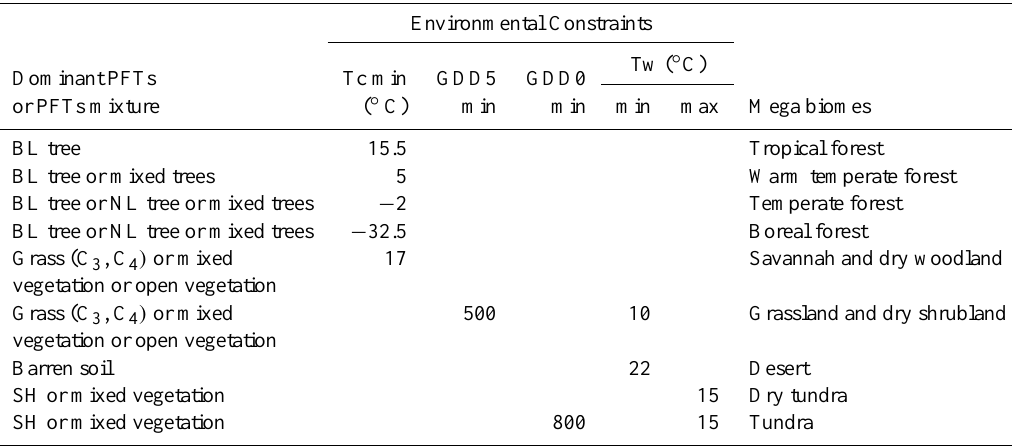
Table 2b. The combination of environmental constraints and potential PFTs are used to compute the biome distribution from UVic ESCM results (Handiani et al.,